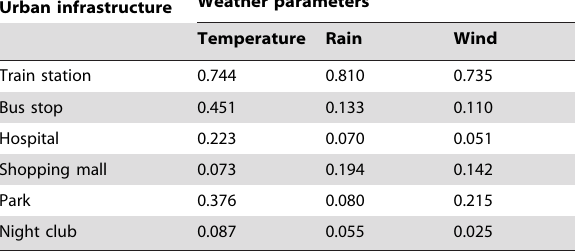
Table 2. The R 2 values representing the correlation between the impact of different weather parameters and accessibility of urban